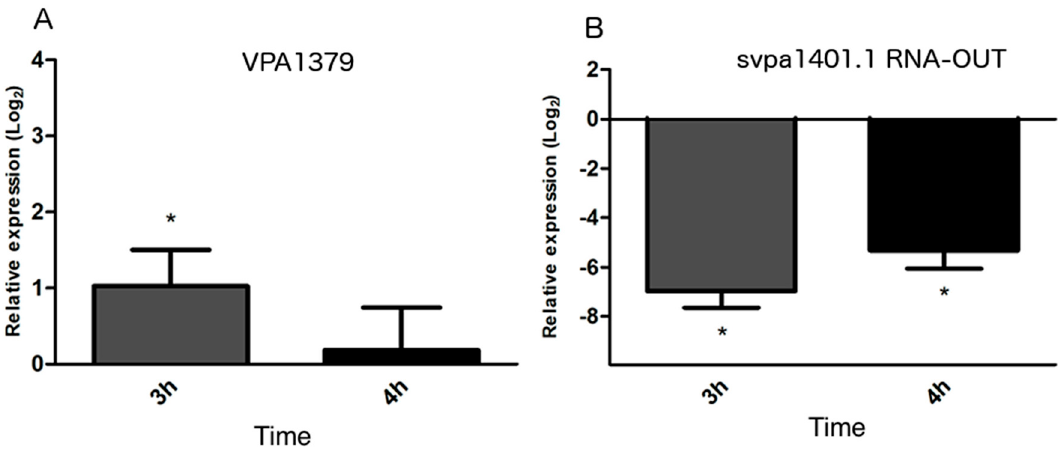
Figure 5. Transcription level of VPA1379 mRNA and svpa1401.1 RNA-OUT during infection of Caco-2 cells. ( A ) VPA1379 mRNA relative expression in 3 and 4hpi; ( B ) svpa1401 RNA-OUT relative expression in 3 and 4hpi. Significant di ff erences of each time compared with 0 hpi (asterisk marks) were considered as p < 0.05 using REST software analysis and statistical